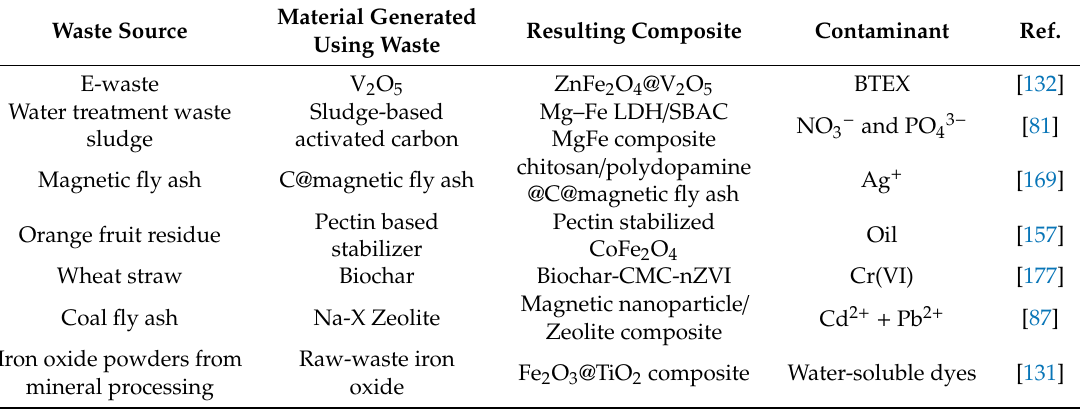
Table 11. Examples of magnetic nanocomposites made using waste